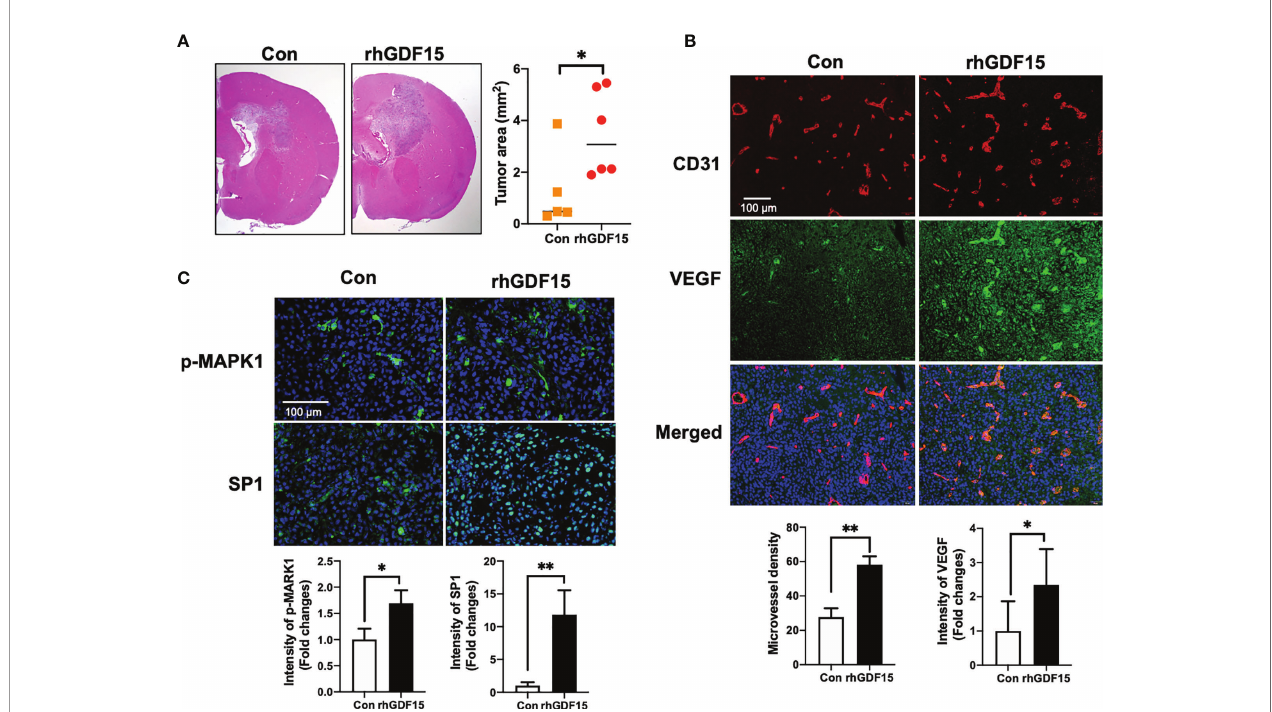
FIGURE 7 | GDF15 promotes angiogenesis by stimulating VEGFA secretion in the brain tumor. (A) Representative section of the brain tumors from mice injected with control U373 cells and rhGDF15-stimulated U373 cells. The brain sections were stained with hematoxylin and eosin. The brain tumor area was measured using ImageJ. (B) VEGFA (green) and CD31-positive endothelial cells (red) in mouse brain tumor tissues were analyzed using immuno fl uorescence staining. Microvessel density was counted as the number of CD31-positive vessels. Scale bar = 100 µm. (C) Representative image of immuno fl uorescence analysis of the phosphorylation of MAPK1 (p-MAPK1; upper panel; green) and expression of SP1 (upper panel; green) counterstained with 4 ′ ,6-diamidino-2-phenylindole (DAPI) (blue). Scale bar = 100 µm. Fluorescence intensity was calculated using ImageJ as follows: Corrected total cell fl uorescence = integrated density − (area of selected cell × mean fl uorescence of background readings). Data are presented as the mean ± standard (control group, n = 5; rhGDF15-treated group; n = 6), * p < 0.05 and ** p < 0.01 compared with control